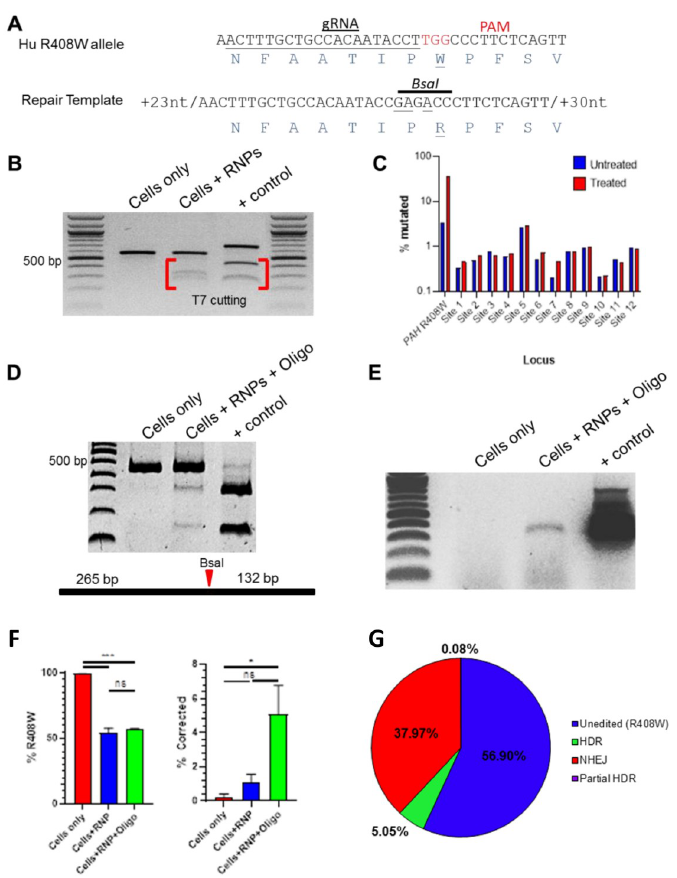
Fig 5. In vitro targeting of humanized PAH R408W and correction by HDR. A) Sequence alignment of humanized pig PAH hR408W (top) showing the guide RNA for the RNPs (grey arrow) as well as a homology template modified to revert the mutation and disrupt the PAM to prevent re-cutting (bottom). The location of the R408W mutation (red letters) and engineered BsaI site are also indicated. B) T7 endonuclease assay of PAH PCR products derived from hR408W fibroblasts, fibroblasts treated with RNPs containing the PAH gRNA, and a positive control for T7 cutting. The presence of the lower/lighter bands indicate mismatched double-stranded DNA indicative of NHEJ resulting from the RNPs. C) Quantitation of amplicon sequences derived from unedited (blue) and RNP treated (red) PCR of the PAH hR408W locus as well as the top 12 predicted off-target cutting sites for the gRNA employed. Only the PAH locus showed indels above background detection levels when compared to untreated samples. D) RFLP with BsaI was negative for untreated hR408W fibroblasts, while the diagnostic bands were present when cells were co-transfected with the RNP and the single stranded oligo template for HDR. Positive control was based on a synthesized dsDNA encoding the intended HDR product. Relative position of the BsaI cut site is diagramed below the gel for reference. E) HDR-specific PCR showed the presence of the anticipated product in co-transfected cells, but not untreated hR408W fibroblasts. The positive control from D, synthetic DNA created to produce the target HDR sequence for analysis, was also evaluated. F) The predominant sequence in untreated cells was R408W, which is reduced in both RNP and RNP/ HT co-transfected cells. G) Pie chart indicating the relative presence of unedited (R408W), NHEJ, HDR (W408R and BsaI site), and incomplete HDR (not all corrections present) species in PAH locus amplicon sequencing from panel F. Gel images presented in B, D, and E are from a single gel each that was abbreviated for presentation as indicated by black vertical